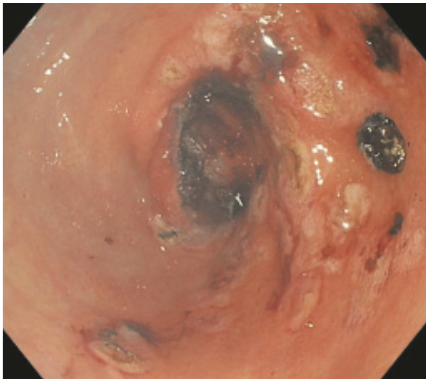
Figure 1: Antral stomach, several small punctate lesions observed.